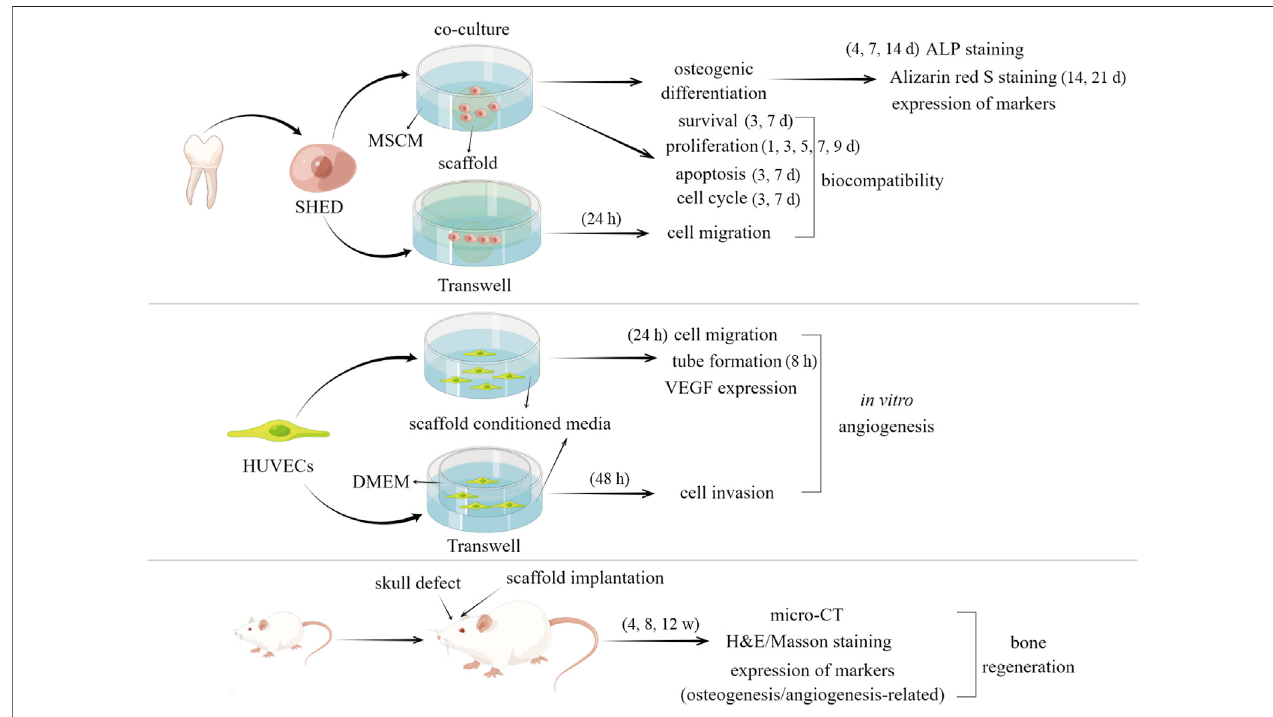
FIGURE 1 | Diagram of the whole process of this